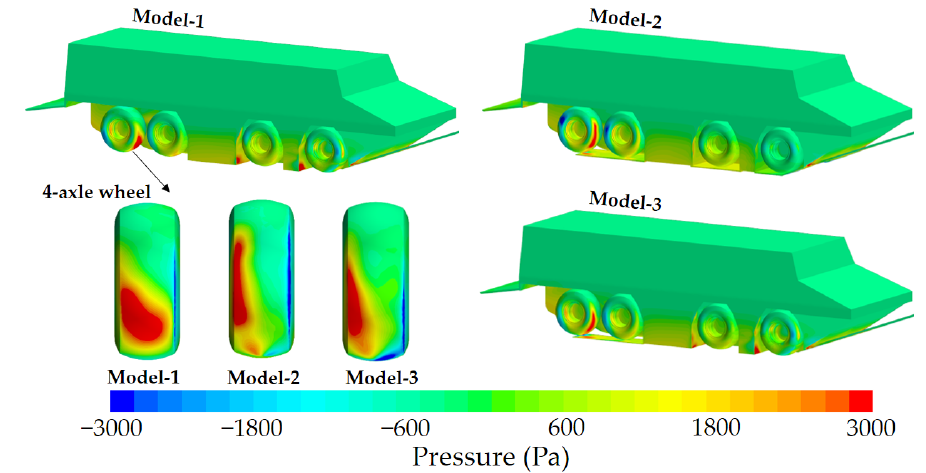
Figure 22. The pressure distribution of the resistance improvement models at Fr = 0.624.